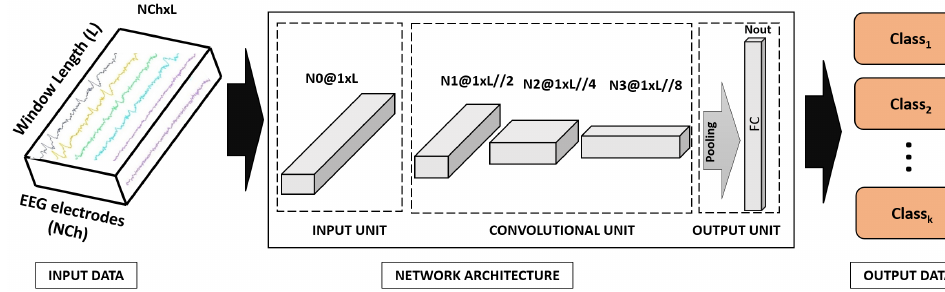
Figure 2. Architecture of the input projector model.